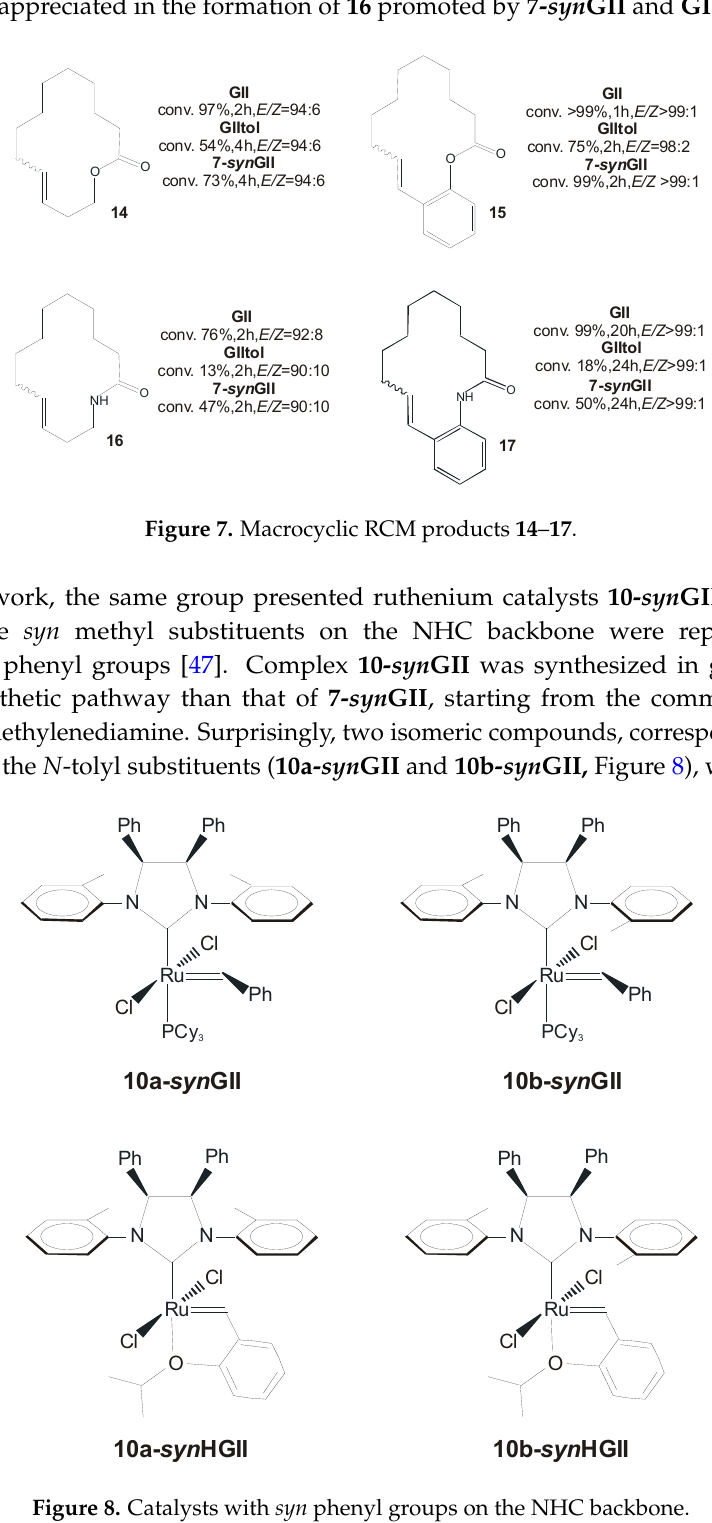
Figure 8. Catalysts with syn phenyl groups on the NHC backbone.